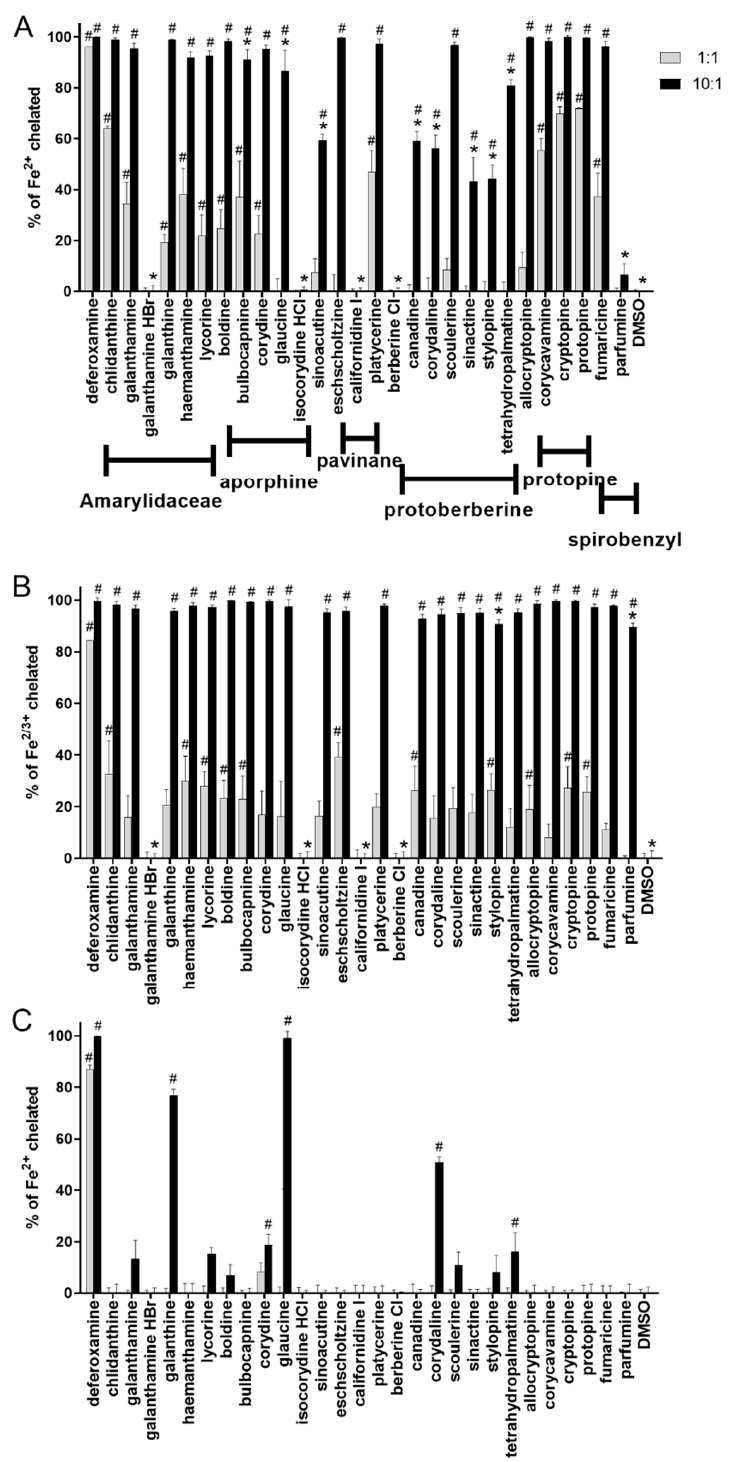
Figure 1. Iron-chelation efficiency of alkaloids in ratios of 1:1 and 10:1 (alkaloid:iron) in comparison with the clinically used iron chelator deferoxamine. ( A ) Ferrous chelation in non-buffered conditions; ( B ) Total iron (ferric + ferrous) chelation in non-buffered conditions; ( C ): Ferrous chelation at pH 7.5: Chelation efficiency of all substances was significantly different from deferoxamine/not shown in the graph/except glaucine at a ratio of 10:1. At a 1:1 ratio, all substances were significantly less potent than deferoxamine under all conditions at p < 0.001. * vs. deferoxamine at p < 0.001, # vs. solvent (dimethylsulfoxide, DMSO) at p < 0.001. Sinoacutine is a morphinane alkaloid.